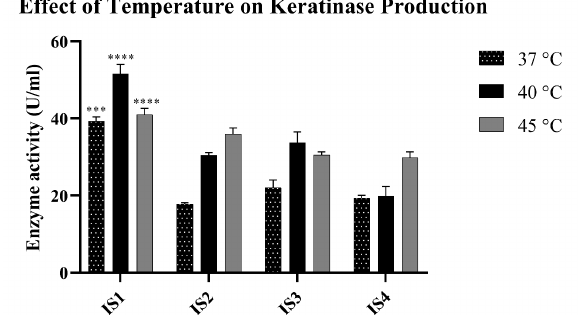
Figure 6. Effect of temperature on the Keratinase activity of the isolates. Graphical representation showing the amount of keratinase activity by the microorganisms at different temperatures. Y-axis indicates the enzymatic activity expressed in U/ml and X-axis denotes the test isolates. Data (n = 3) illustrated in the bar diagram as mean +SD. ****p < 0.0001 as determined by Two-way ANOVA (IS1 to IS4 represents the isolates). Though the enzymatic activities of IS1 at 40 °C, and 45 have the same statistical significance, the activity at 40 °C was much higher than that at 45 °C.